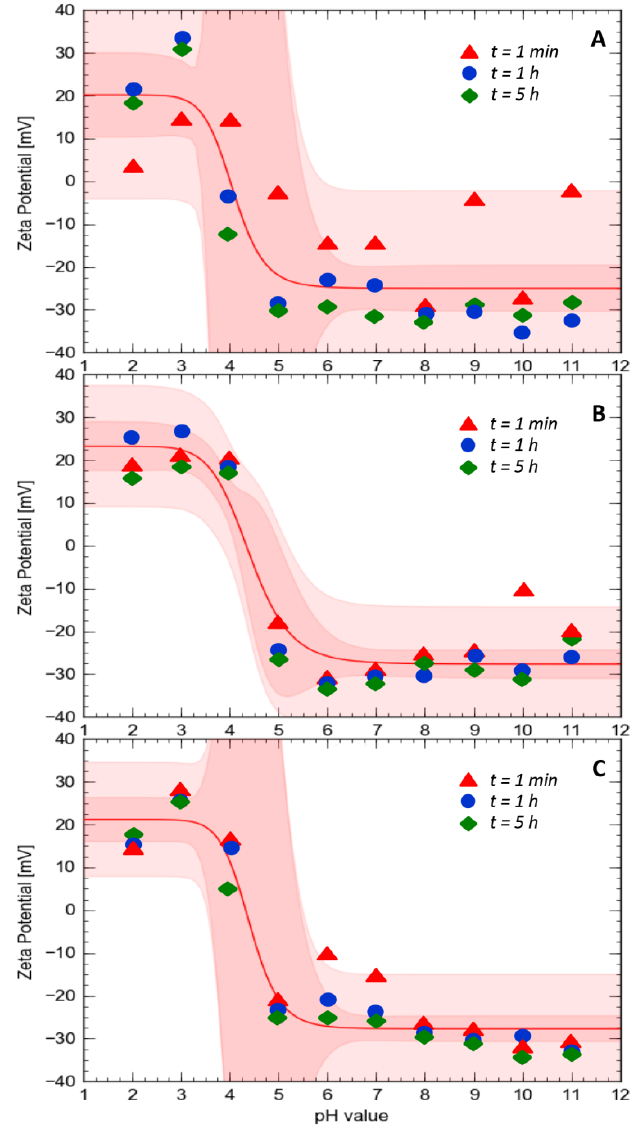
Figure 1. Zeta potential of α S1 CN ( A ), β CN ( B ) and κ CN ( C ) as a function of pH. The red line represents the sigmoidal fit trend line. Darker red indicates a confidence band, while lighter indicates a prediction band.